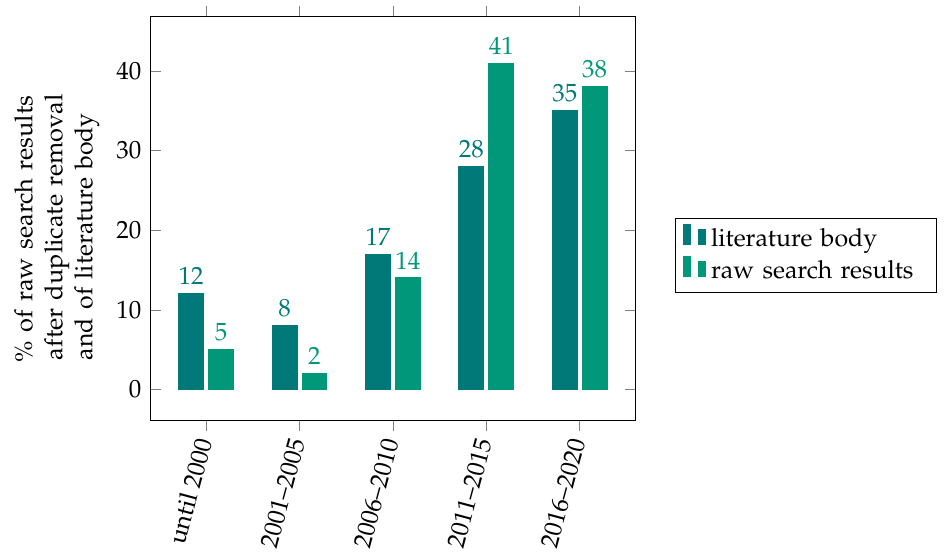
Figure 4. Chronological distribution of publications in raw search results and in literature body.